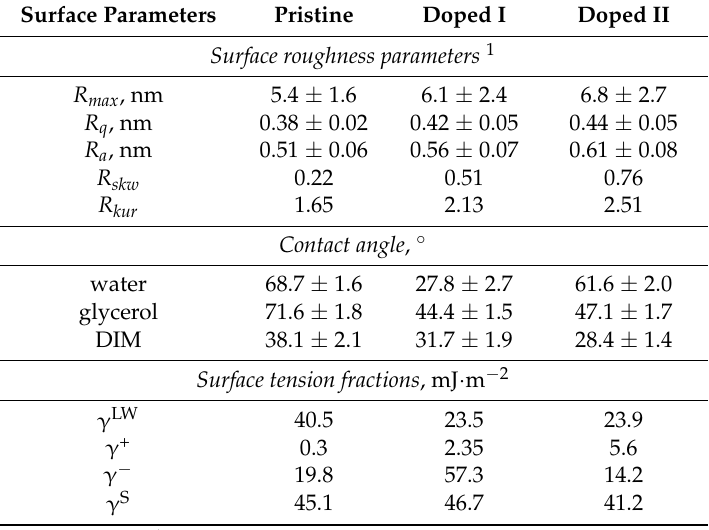
Table 3. Contact angle and surface tension for pristine and doped polyterpenol thin films fabricated at 25